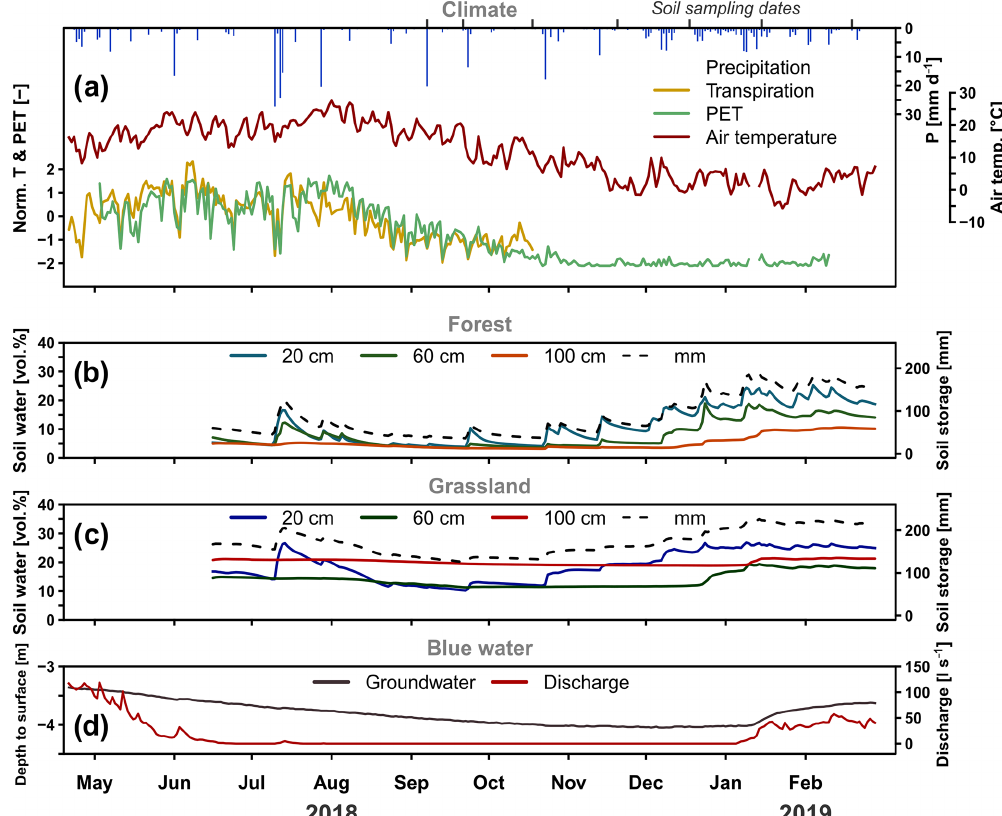
Figure 2. Daily precipitation, normalised transpiration (from sap-flow sensors), normalised PET (FAO Penman–Monteith) (a) , volumetric soil moisture ( n = 6 per three depths of the forested plot) (b) , and grassland site (c) with the total soil water in millimetres (dashed line) and groundwater elevation relative to surface and discharge at the Demnitz Mill (d) for the 2018 growing season and 2019